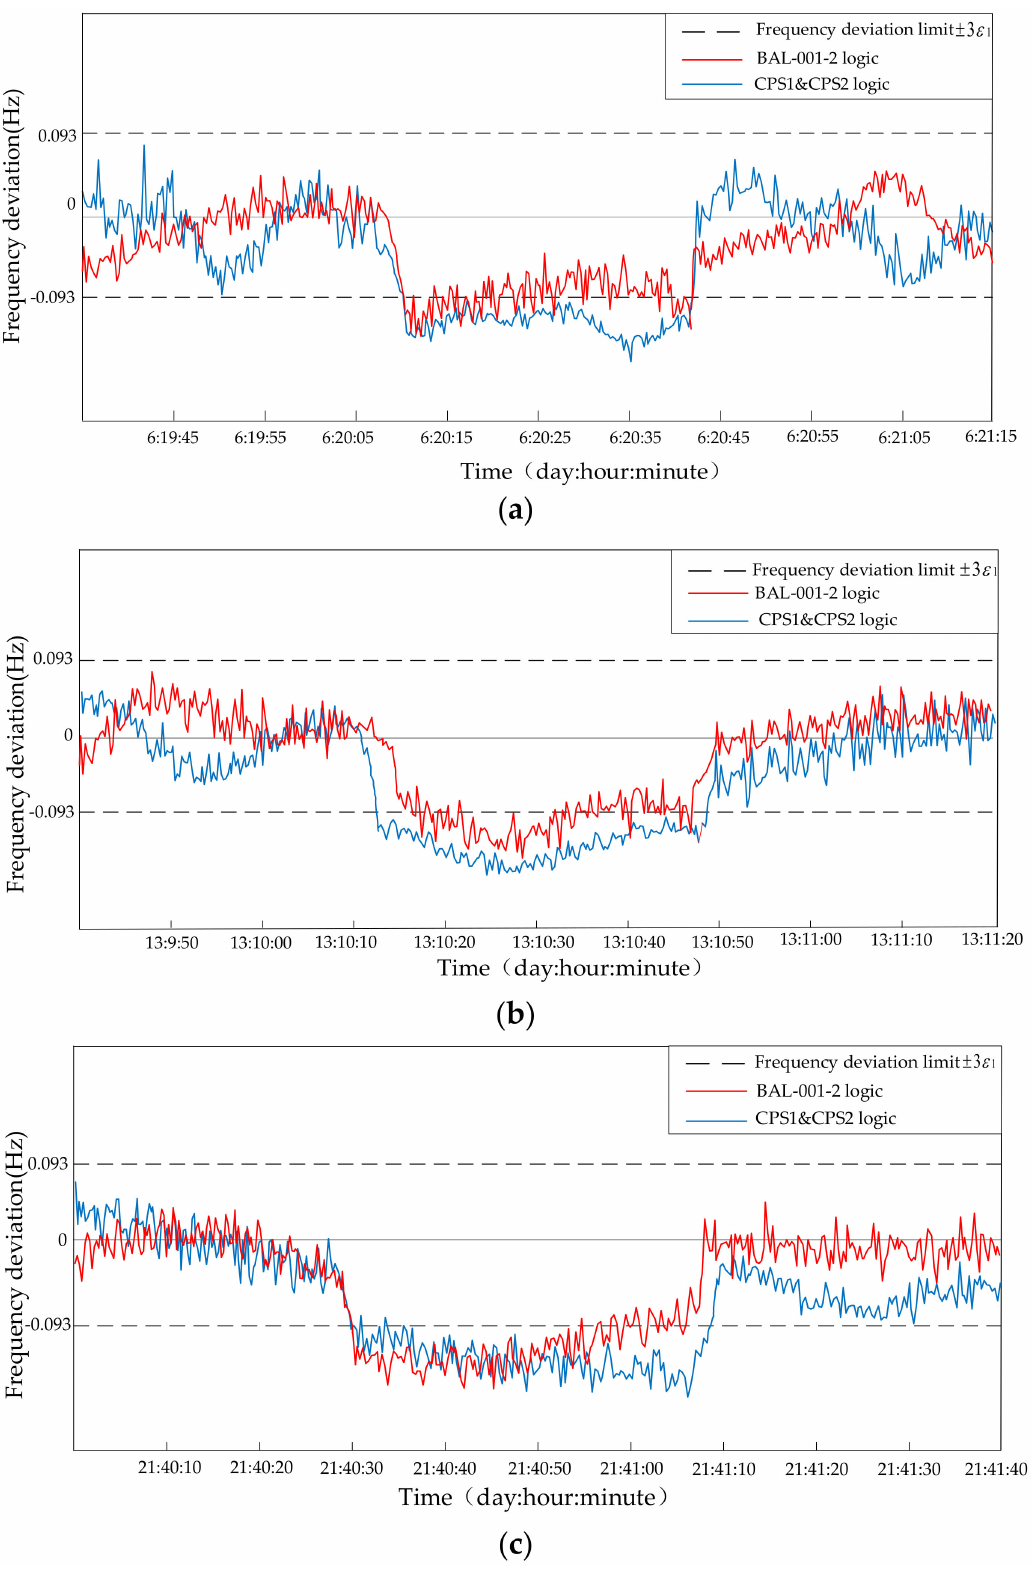
Figure 6. Three conditions of frequency deviation fluctuation with the CPS1&CPS2 logic and the BAL-001-2 logic: ( a ) condition 1; ( b ) condition 2; ( c ) condition